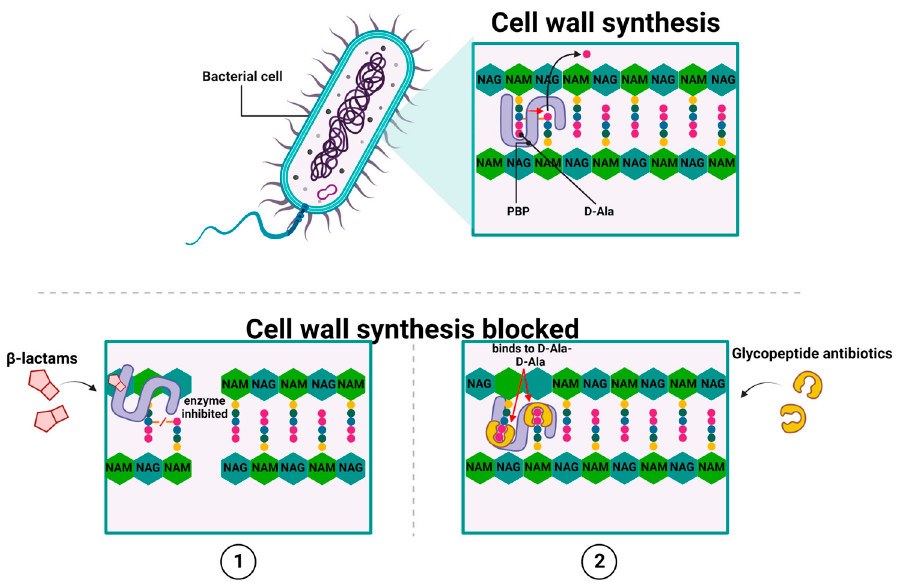
Figure 1. Bactericidal mechanism of ( 1 ) β -lactams and ( 2 ) glycopeptide antibiotics; NAG— N - acetylglucosamine, NAM— N -acetylmuramic acid. Figure created with Biorender.com.